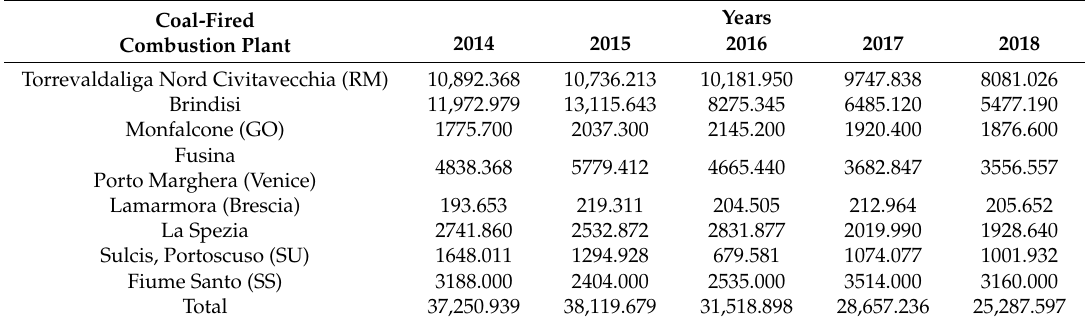
Table 4. Total carbon dioxide equivalent emissions (Gg CO 2 eq) from coal-fired combustion plant in Italy